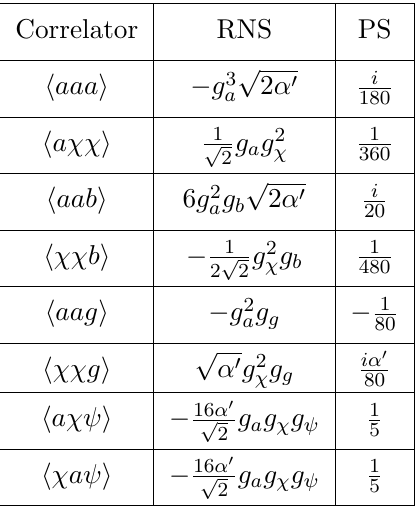
Table 1 . Numerical factors of RNS and pure spinor